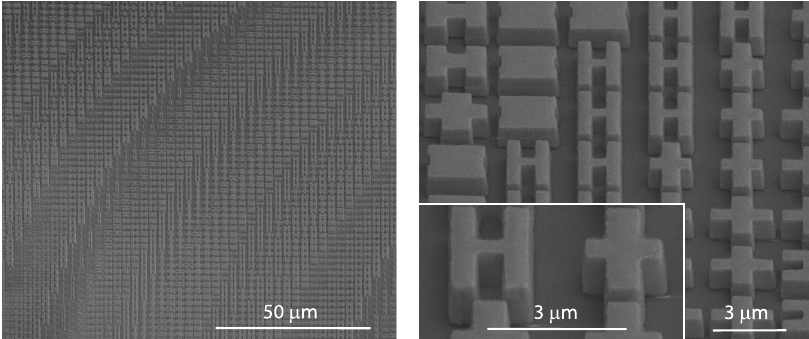
Fig. 3 SEM scans of the metalens. The images show the GSST meta-atoms with vertical sidewalls and excellent pattern fi